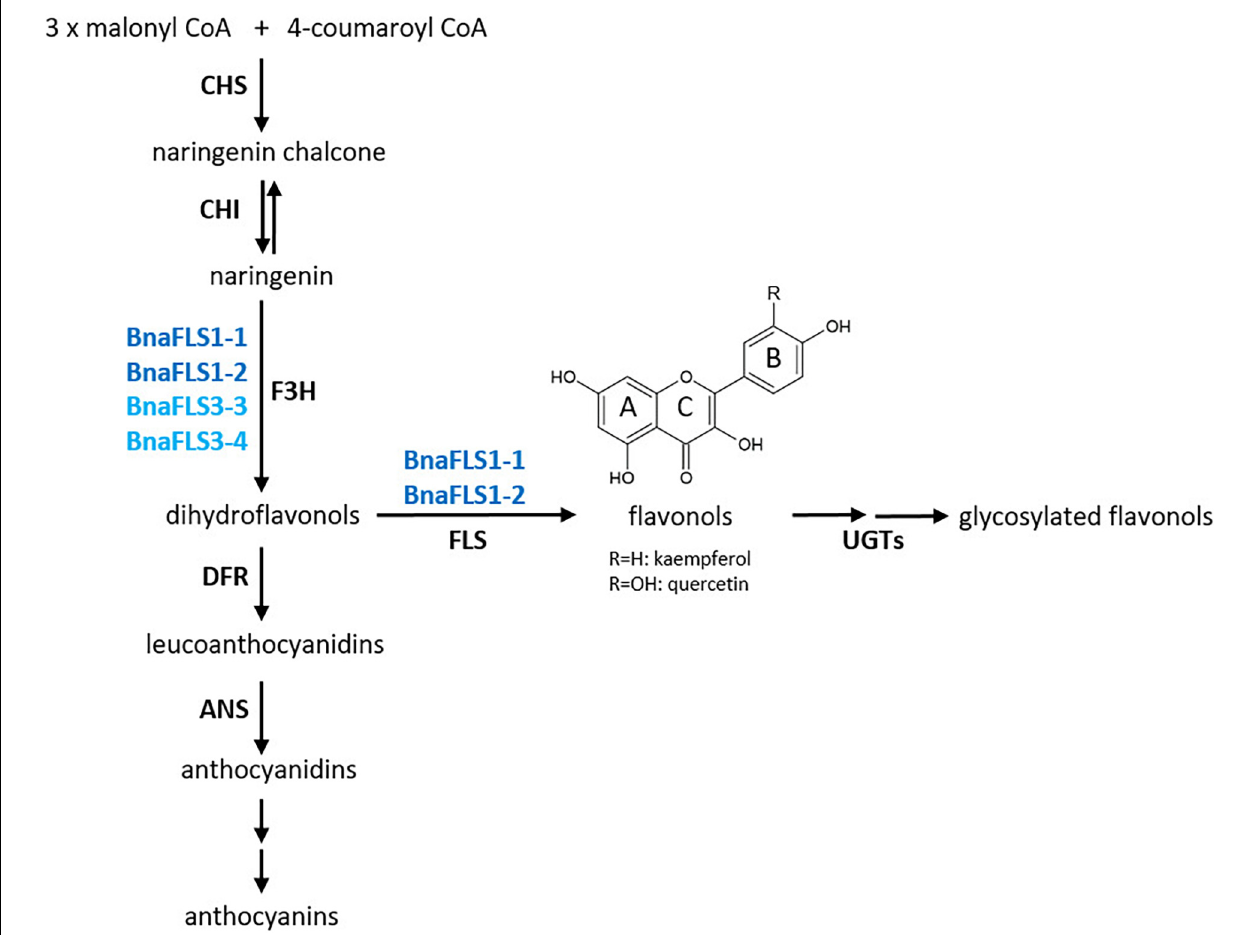
FIGURE 8 | Functional activities of the B. napus flavonol synthase family. BnaFLS1-1 and BnaFLS1-2 marked in dark blue, are bifunctional enzyme exhibiting F3H and FLS activity. BnaFLS3-3 and BnaFLS3-4 labeled in light blue possess F3H